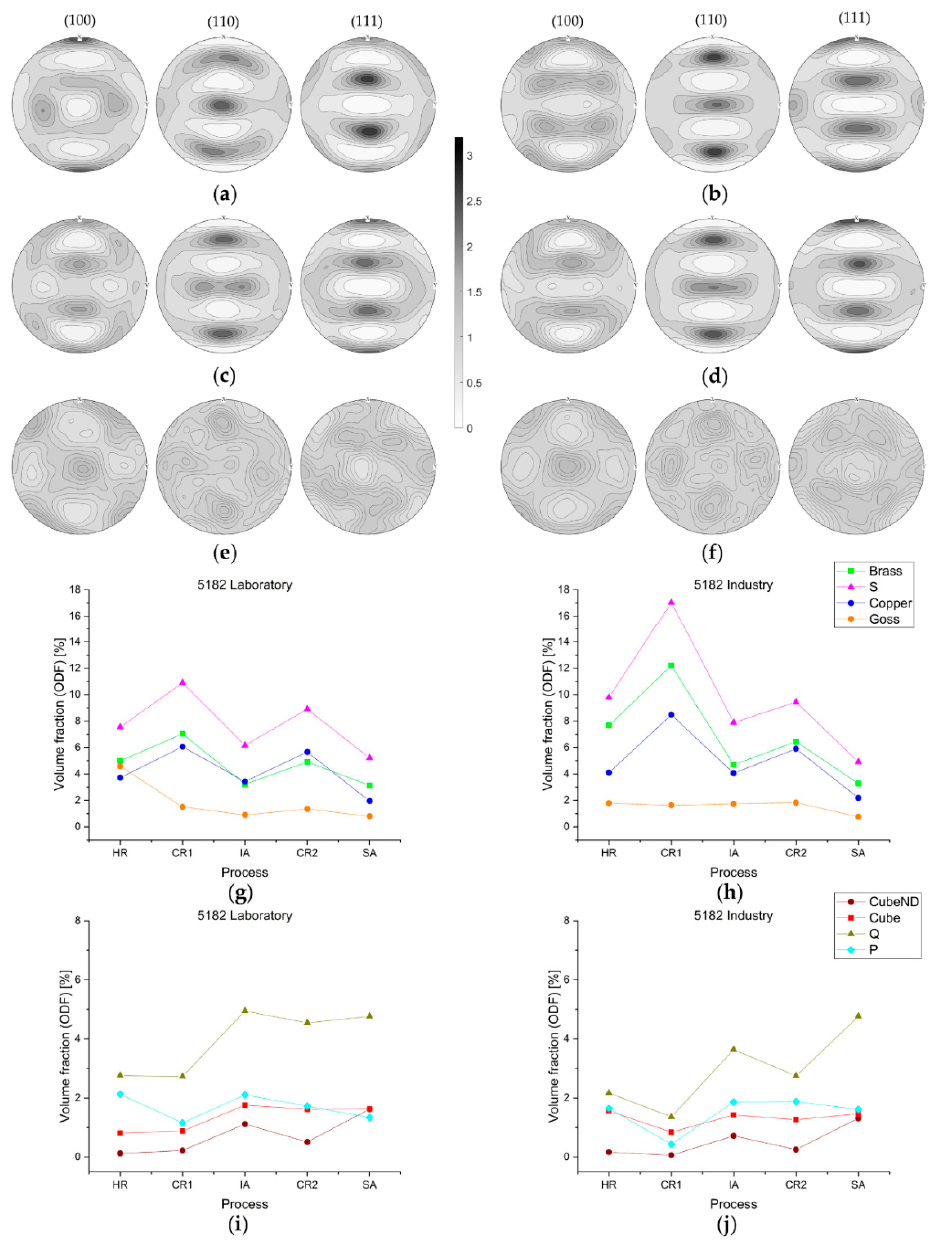
Figure 6. Evolution of texture components within sheet processing for EN AW-5182; (001), (110), and (111) pole figures based on ODF data for ( a ) hot rolling (HR) laboratory, ( b ) HR industry, ( c ) cold rolling (CR)2 laboratory, ( d ) CR2 industry, ( e ) soft annealing (SA) laboratory, and ( f ) SA industry; diagrams ( g – j ) show the evolution of specific texture components over the entire processing